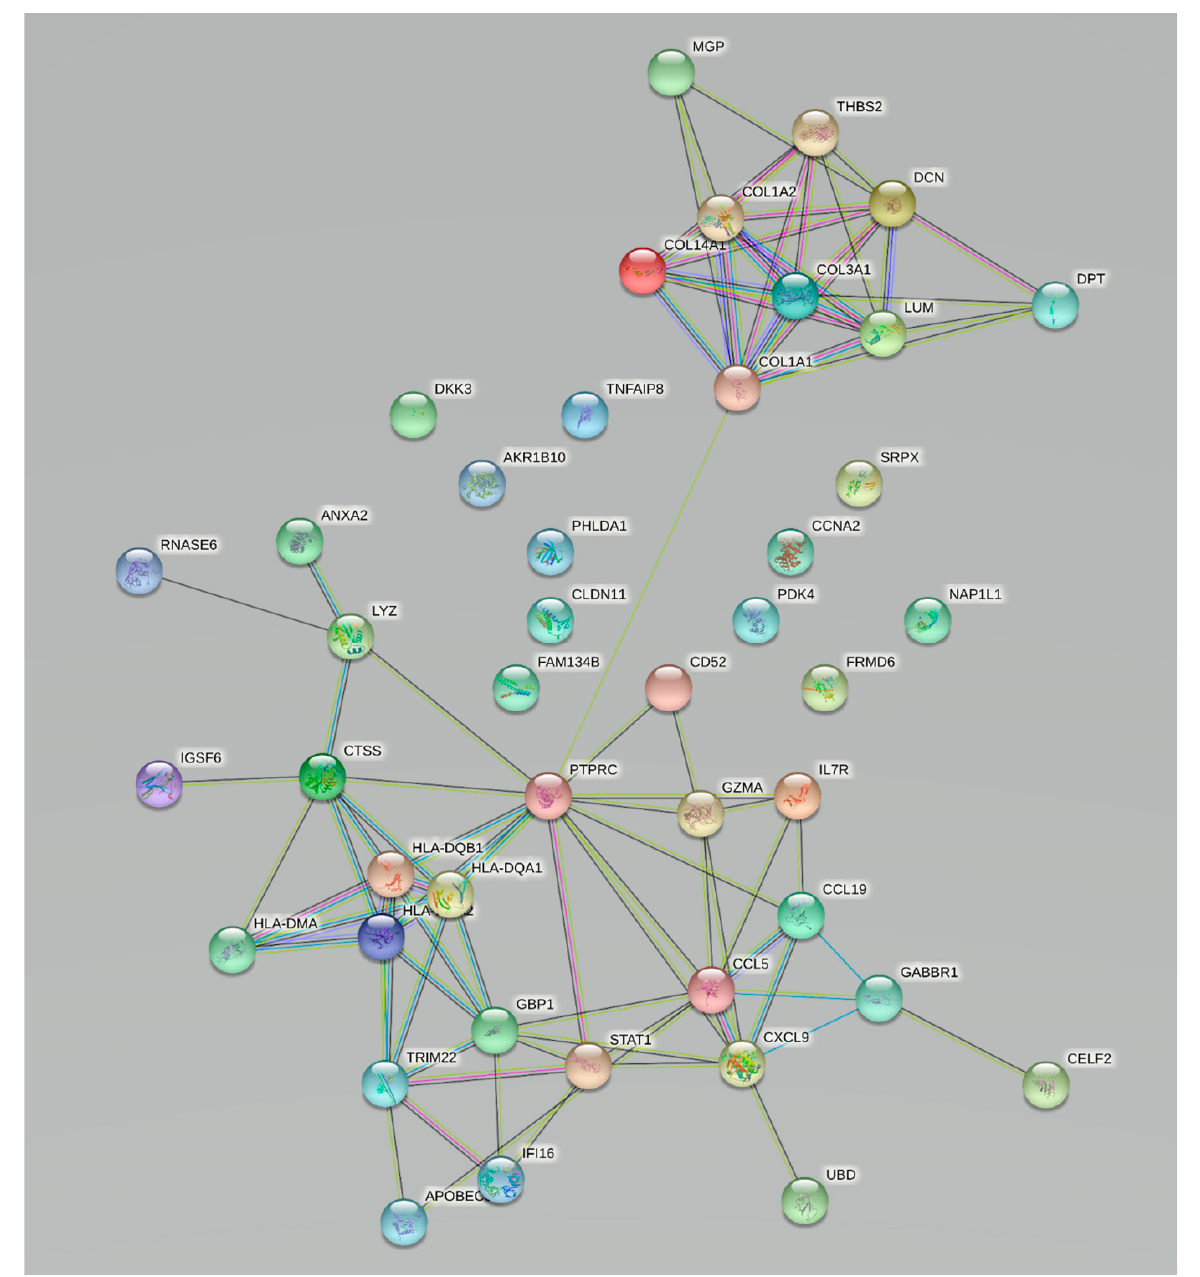
Figure 1. Protein–protein interaction network of intersection of significantly deregulated genes between kidney and liver fibrosis. Table 1. Differences in expression of six chosen genes between normal and fibrotic tissue expressed as fold change in kidney and liver tissue. Legend: logFC, logarithm of fold change.